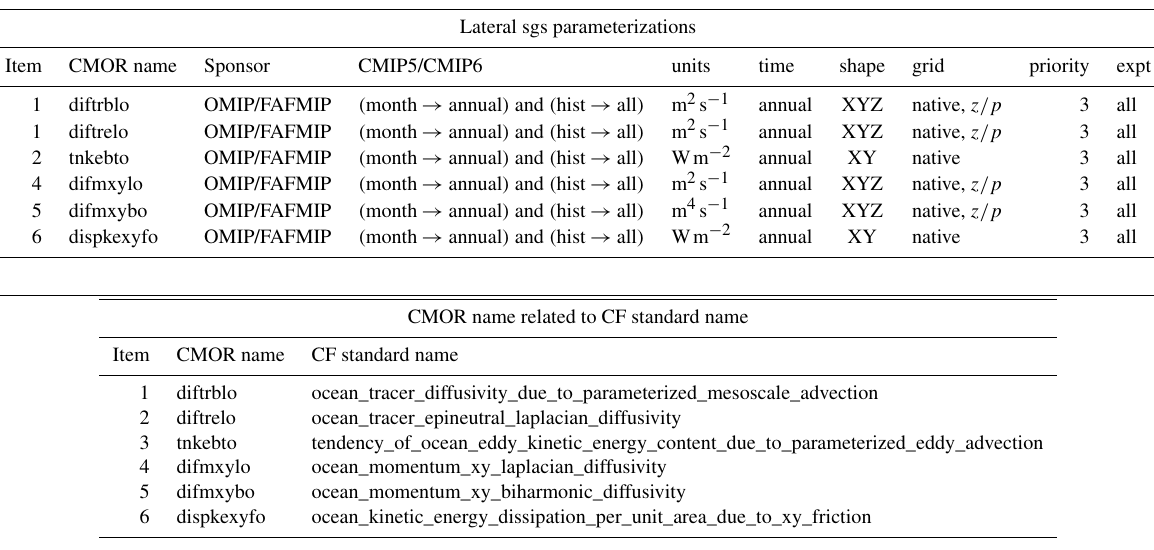
Table N1. This table summarizes diagnostics that support the study of lateral subgrid-scale (SGS) parameterizations. The column indicating the experiment for saving the diagnostics generally says “all”, in which case we recommend the diagnostic be saved for CMIP6 experiments in which there is an ocean model component, including the DECK, historical simulations, FAFMIP, DAMIP, DCPP, ScenarioMIP, and C4MIP, as well as the ocean/sea-ice OMIP simulations. We ask only for annual means from these fields, rather than the monthly means requested for most other diagnostics. Additionally, this table has been reduced from the 10 fields requested in CMIP5 to the 6 requested here. Furthermore, note that the fields tnkebto and dispkexyfo were requested as three-dimensional fields for CMIP5, whereas they are now requested as depth-integrated two-dimensional fields. The lower sub-table lists the CMOR names and the corresponding CF standard